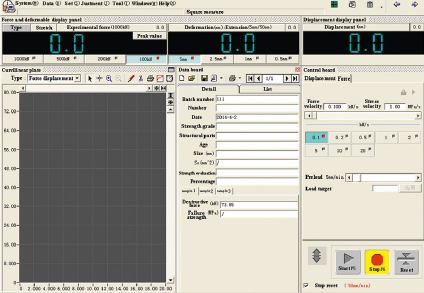
Figure 28: Connector.